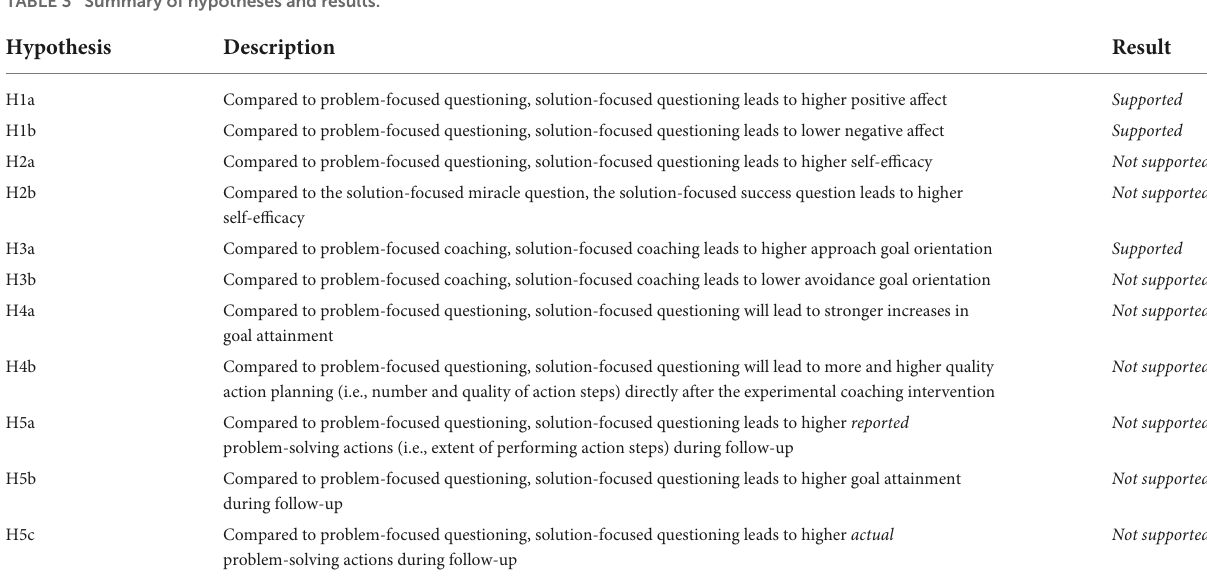
TABLE 3 Summary of hypotheses and